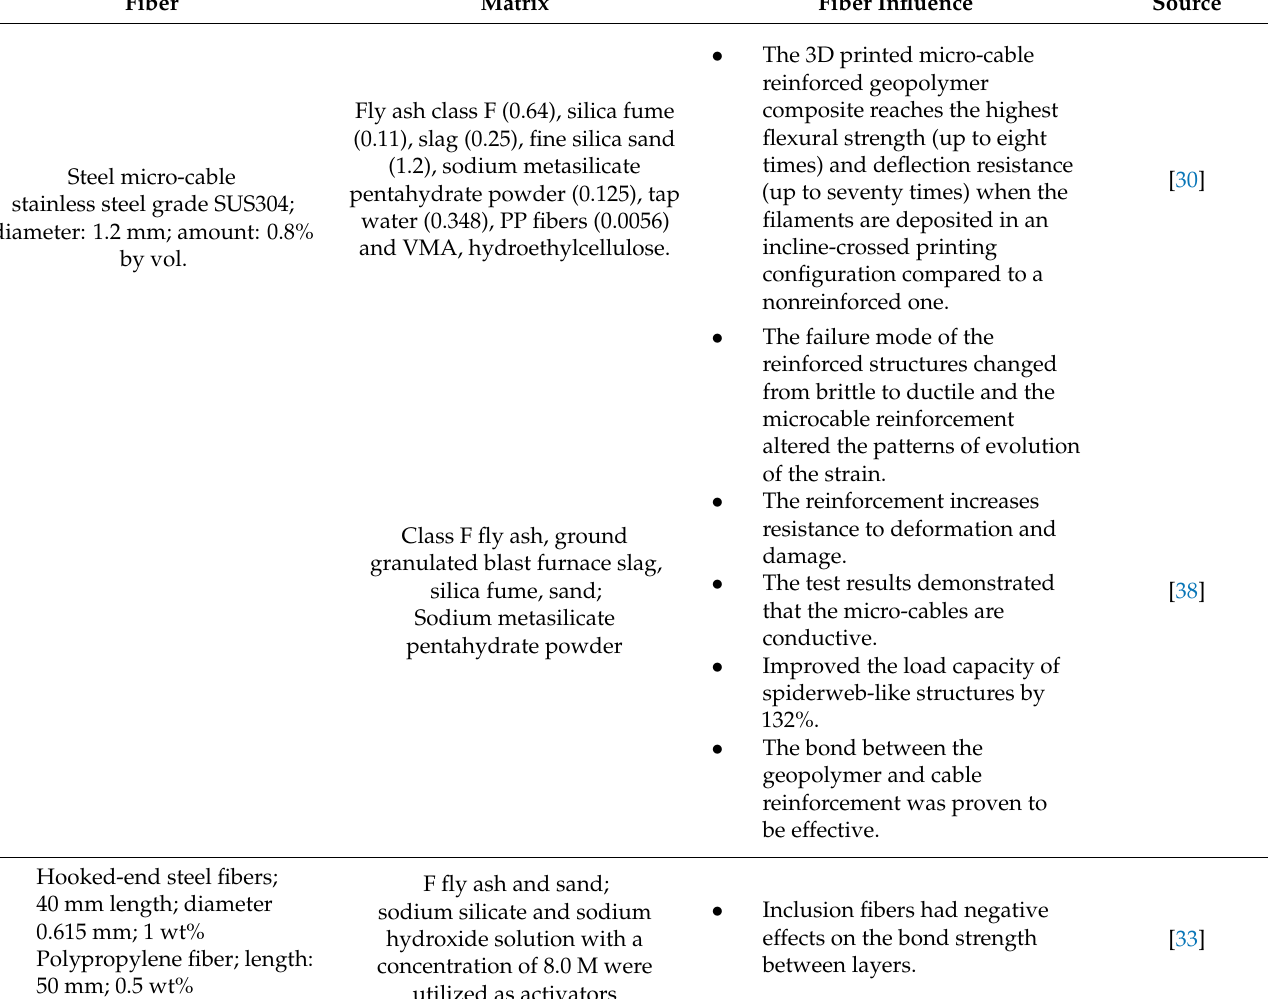
Table 1. Types of fibers used in geopolymer composites manufactured by 3D